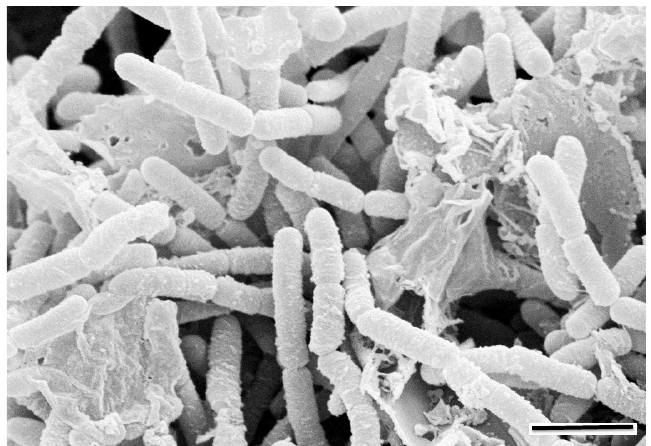
Figure 1. A SEM micrograph showing a matured biofilm consisting of both grown cells and extracellular polymeric materials on surface of a rock under moist conditions (scale bar, 2 µ